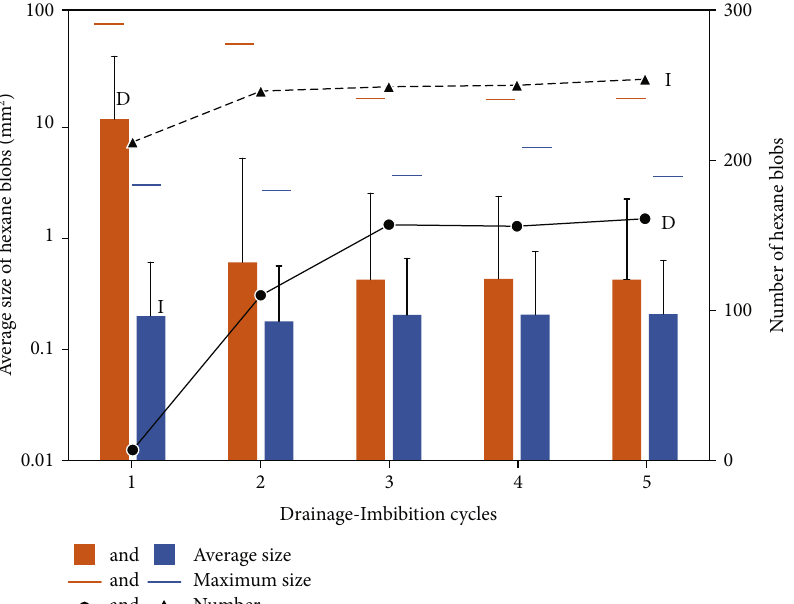
Figure 12: Average and maximum size and number of hexane blobs and clusters after the completion of the drainage-imbibition